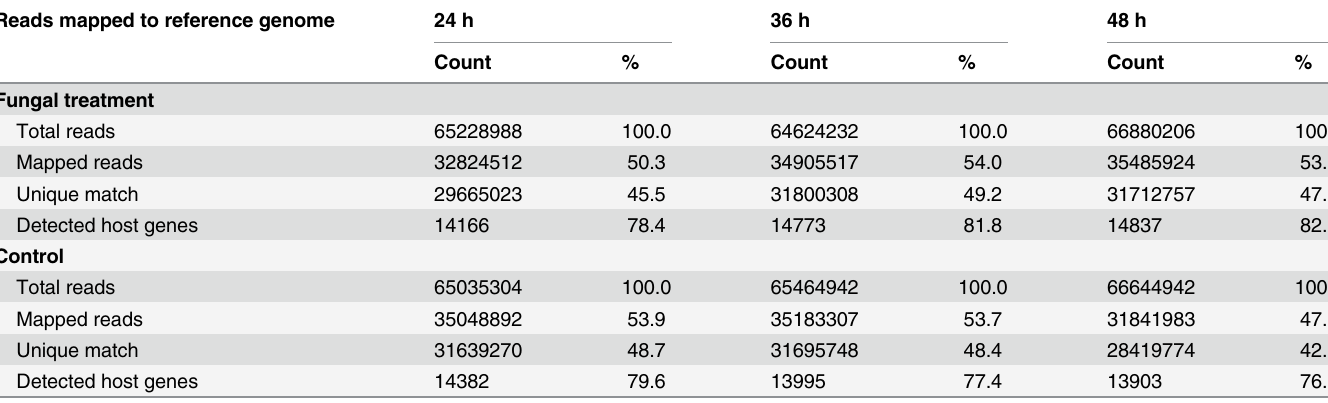
* The percentage (%) for the mapped reads or the unique match is based on the count of total reads while the percentage for the detected host genes is based on the number of P . xylostella genes (18071).